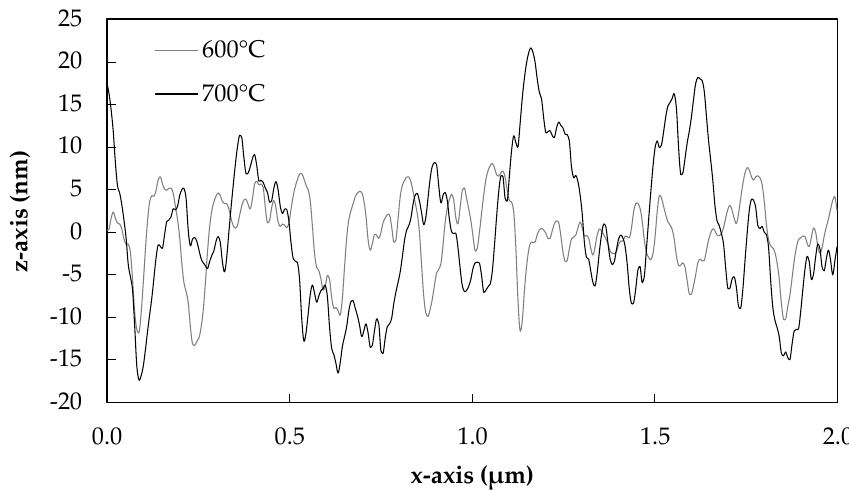
Figure 8. Typical 2D sections of the surface topography after heat treatment at 600 and 700 °C.